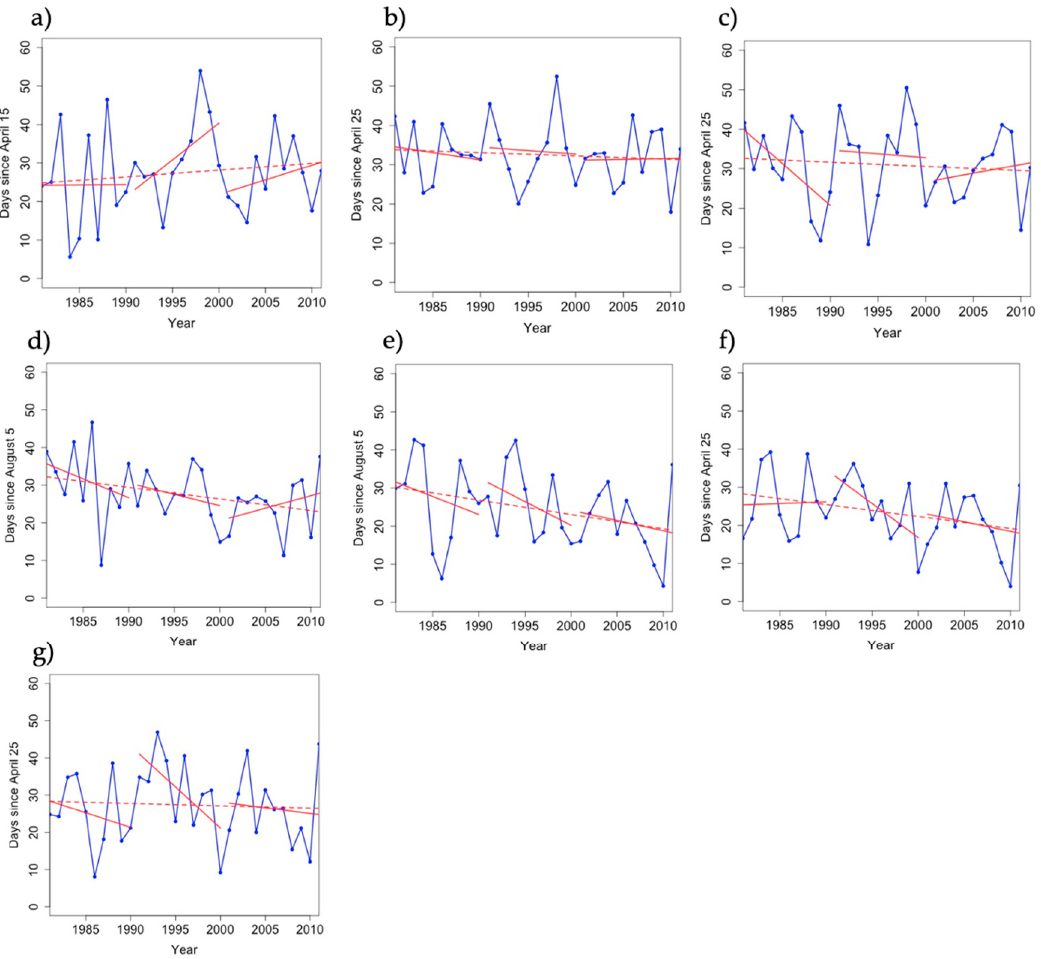
Figure 4. Yearly zonal mean onset dates (blue line) with linear trend line for the entire period (1980–2010) (dashed red line) and each decade (red line) for ( a ) Northwest (Z1), ( b ) Northeast (Z2), ( c ) North Central (Z3), ( d ) Central Coast (Z4), ( e ) South Central Coast (Z5), ( f ) Central Highlands (Z6), and ( g ) South (Z7) agroclimatic zones.